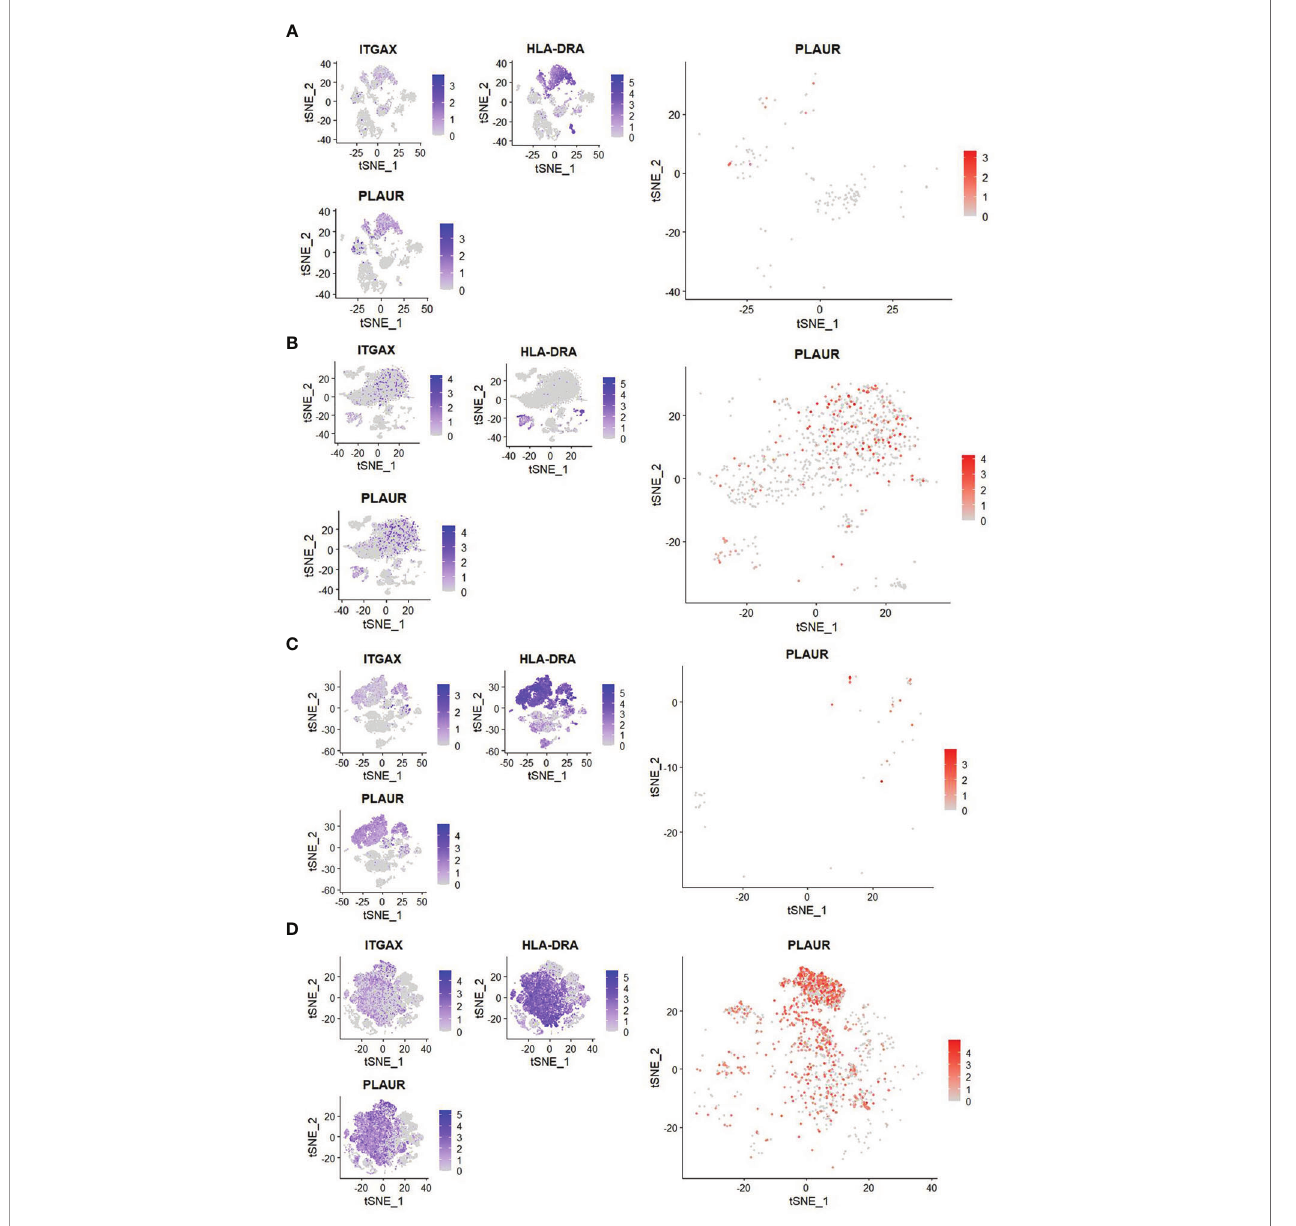
FIGURE 2 | Reanalysis of single-cell sequencing data to con fi rm myeloid sourcing of suPAR. (A, B) Analysis of scRNAseq data (GSE163668) to compare the frequency of peripheral blood CD11c high HLA-DR low cells and expression of PLAUR in them between patients with mild (left panel) or severe (right panel) COVID-19 disease. (C, D) Analysis of scRNAseq data (GSE GSE145926) to compare the frequency of CD11c high HLA-DR low cells in the bronchoalveolar lavage fl uid and the expression of PLAUR in them between patients with mild (left panel) or severe (right panel) COVID-19 disease. In both cases, three smaller plots on the left show distribution of expression of ITGAX (gene for CD11c), HLA-DRA (gene for HLA-DR), and PLAUR (gene for uPAR) among all cells. The bigger plot on the right shows expression of PLAUR among CD11c high HLA-DR low